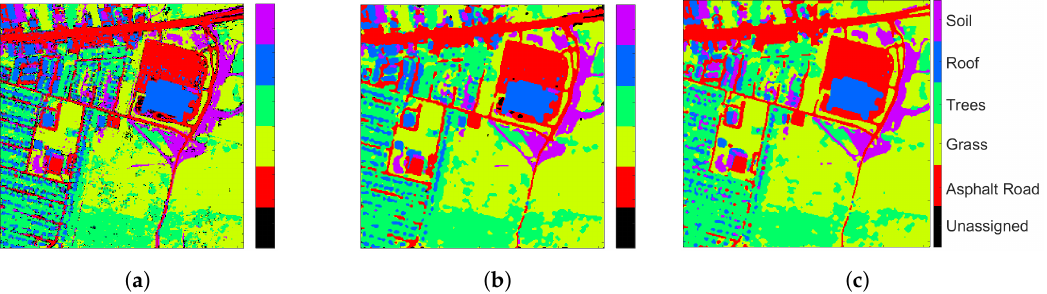
Figure 19. Urban Image: ( a ) classification map derived from the abundances using winner takes it all and 50%threshold; ( b ) classification map after median filtering; ( c ) reference data classification map